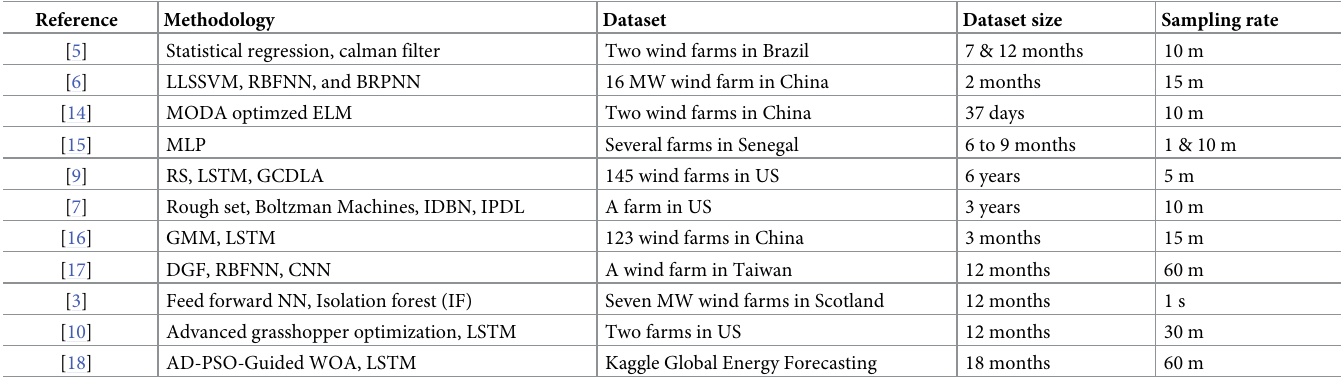
Table 1. Recent research approaches for wind power forecasting, m and s indicate minutes and seconds, respectively.